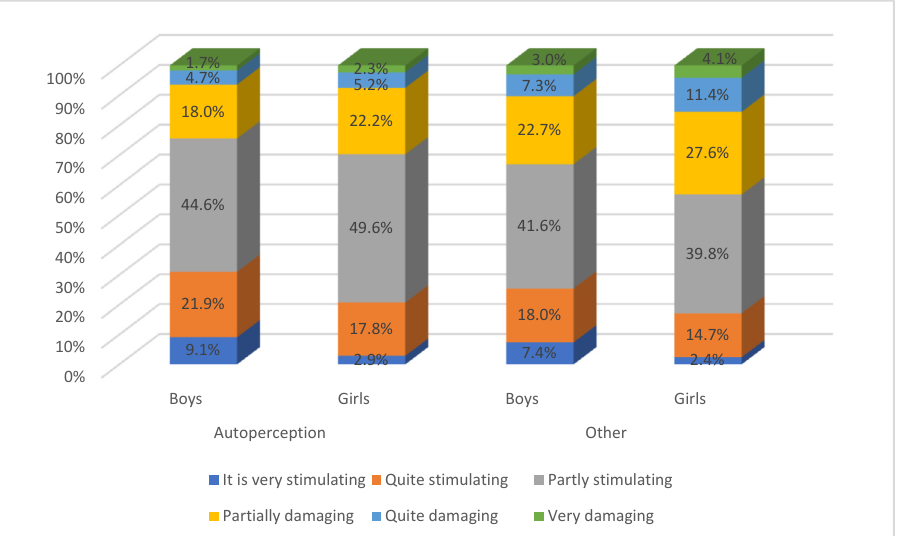
Figure 12. Perception of the impact of the internet by gender.